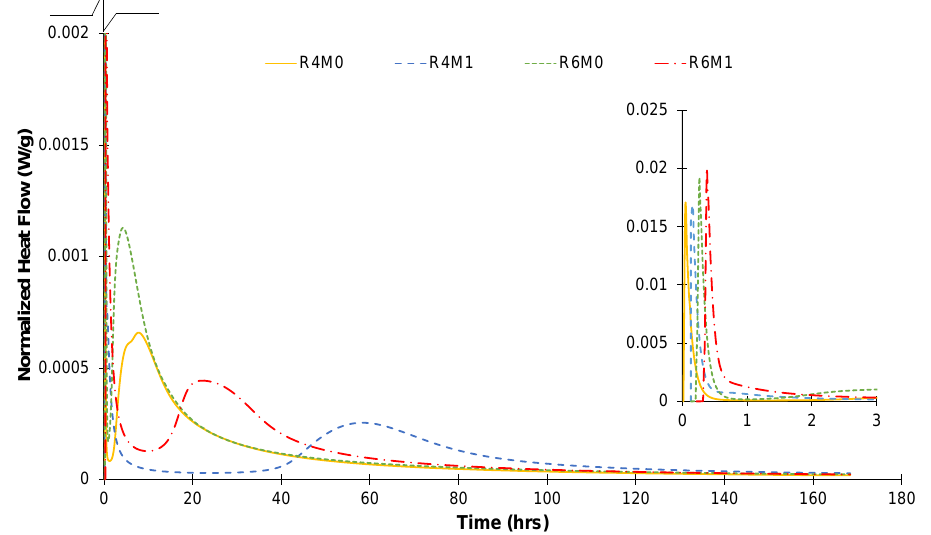
Figure 6. Effect of activators on heat evolution of RAP aggregate mortars.